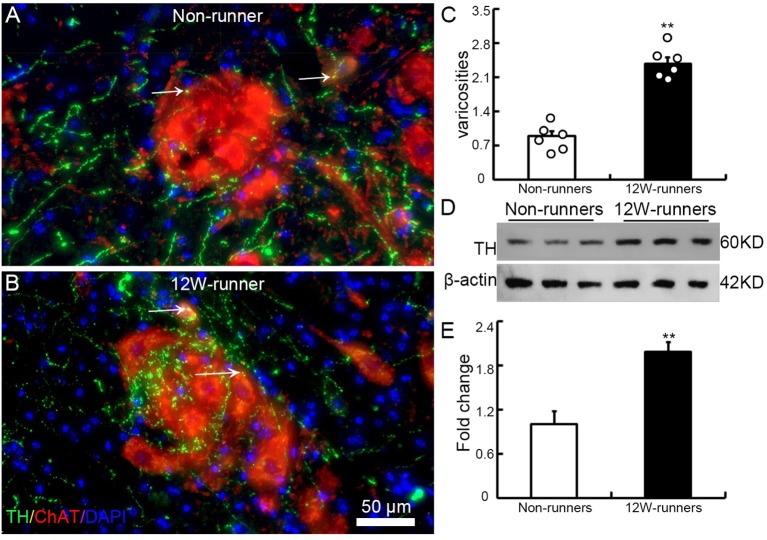
Training induces increased contacts between dopaminergic axons and spinal motor neurons. (A,B) Illustration of contacts between TH-positive varicosities and cholinergic neurons in a non-runner (A) and a runner after training (B) the white arrows indicate “contacting varicosities between 5-HT fibers and ChAT-positive neurons”. (C) Quantification of TH-positive varicosities. Each circle represents the data from one animal. **P < 0.01; n = 6 for each group. (D) Western blot analysis of TH protein content in three non-runners and three runners, relatively to β-actin control, with quantification. (E) Statistics of protein levels. **P < 0.01.